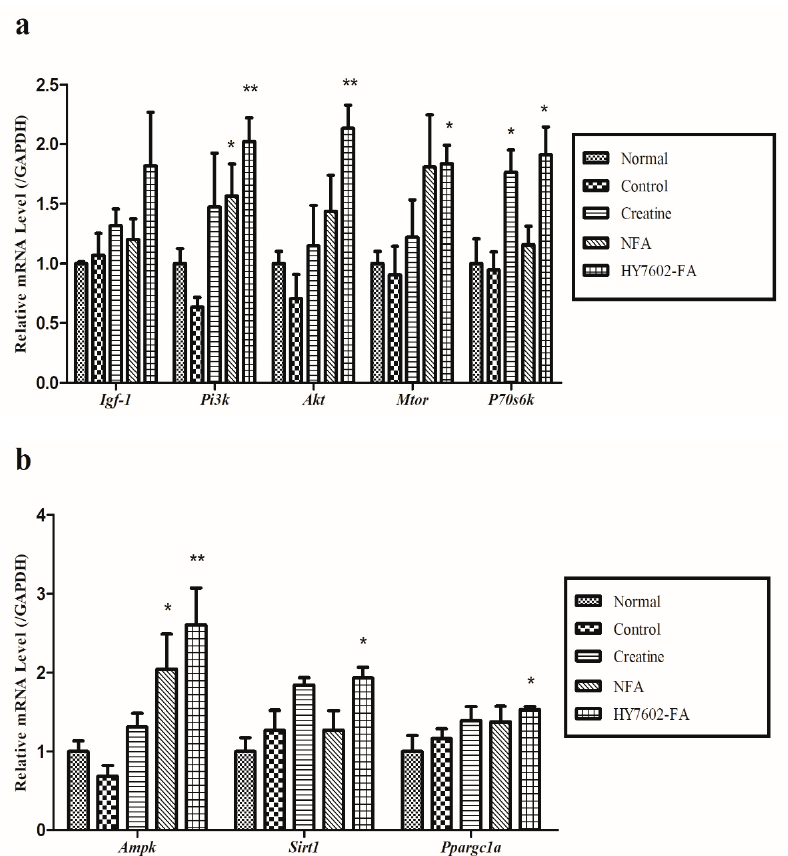
Figure 6. Effect of HY7602-FA on expression of mRNA encoding genes related to muscle protein synthesis, mitochondrial biogenesis, and exercise signaling pathways in skeletal muscle tissue. ( a ) Expression of Igf-1, Pi3k, Akt, Mtor , and P70s6k (related to muscle protein synthesis) in mouse skeletal muscle tissue was detected by RT-PCR. ( b ) Expression of Ampk, Sirt1 , and Ppargc1a , which are known to be important for mitochondrial energy supply and metabolism in mouse skeletal muscle tissue, were detected by RT-PCR. All data represent the mean ± SD ( n = 9 mice per group); asterisks indicate significant differences: * p < 0.05 and ** p < 0.01 vs. control group. NFA, non-fermented antler; FA, fermented antler.